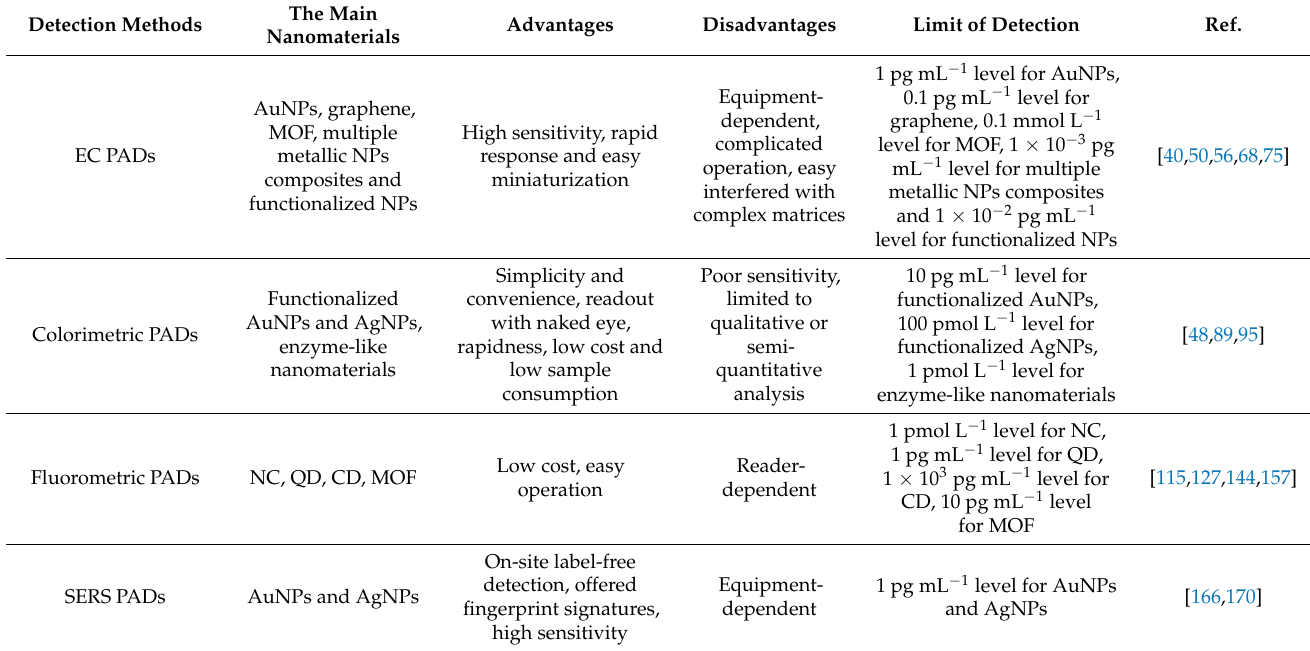
Table 5. The comparison of four representative detection methods of